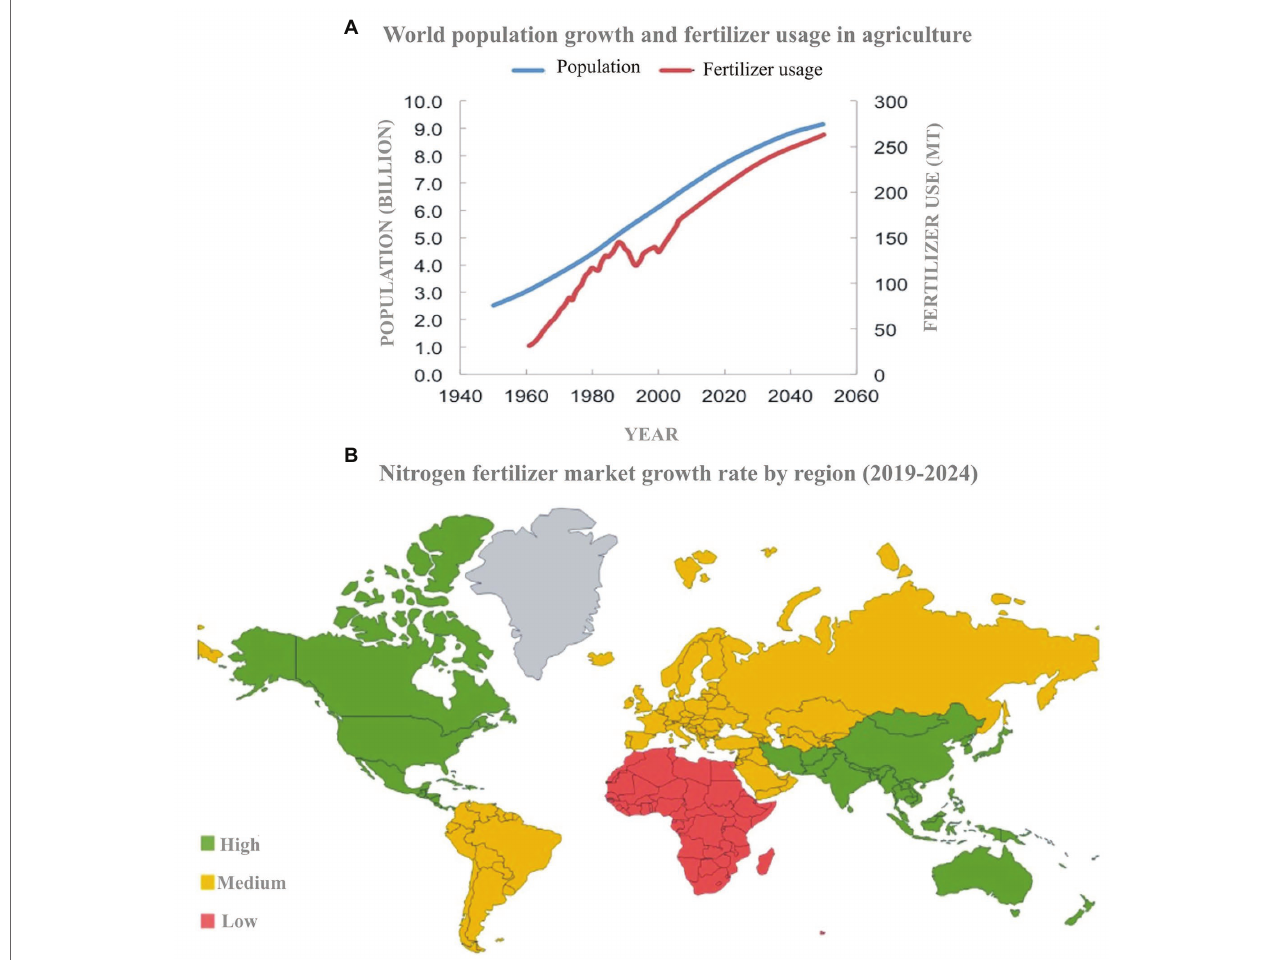
FIGURE 1 | Fertilizer usage and population growth trends in the last 100 years and future prediction (source: Meer, 2016; A ). Map showing the region-wise N-fertilizer input into the agricultural system (source: Mordor Intelligence; B